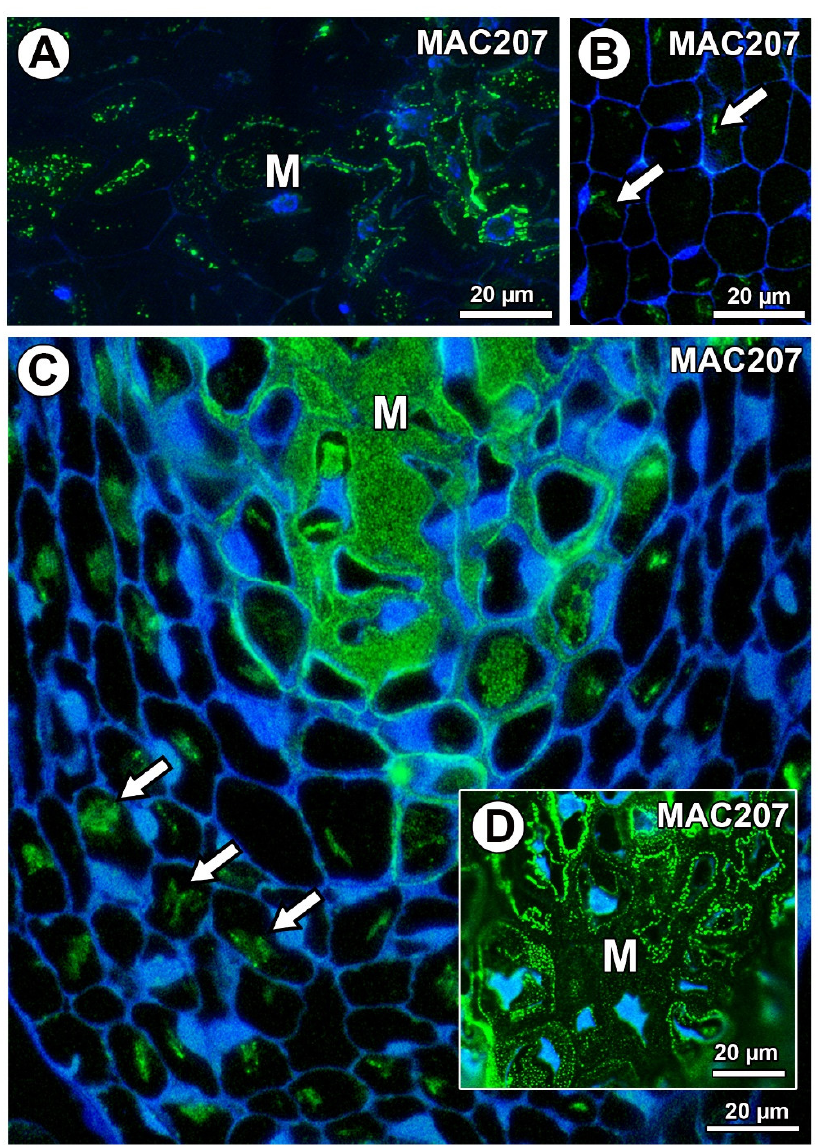
Figure 8. Arabinogalactan protein (labeled with MAC207) detection. ( A ) AGP detection in mucilage cells (M) in Taraxacum officinale ovule. ( B ) Association between AGPs and calcium oxalate crystals (arrows) in parenchyma cells of T. officinale ovule. ( C , D ) Section through the ovule of Pilosella officinarum ; note the occurrence of AGPs in the mucilage cells (M) and the association between AGPs and calcium oxalate crystals (arrows).